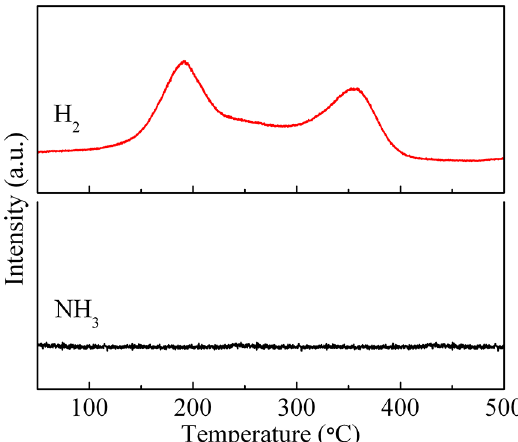
- and NH Figure 2. H 2 LiNH mixture 2